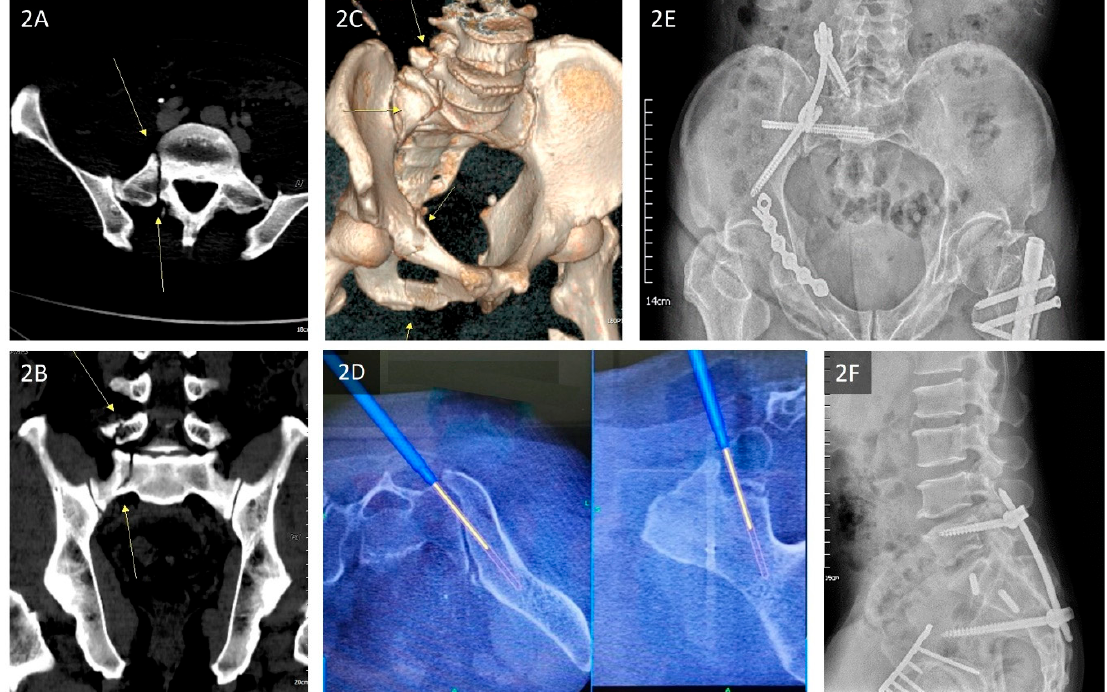
Figure 2. ( A – F ) Pre- and postoperative radiography and CT images of a 56-year-old man who was hit by a vehicle and had right superior and inferior rami fractures, a right L5 transverse process fracture, and a right sacral fracture with spinopelvic dissociation. The associated injury included a left femoral shaft fracture, right femoral shaft segmental fracture, and left medial malleolar fracture. ( A ) Axial CT view of the sacrum on admission demonstrating fracture lines (yellow arrows) over the right L5 transverse process; ( B ) coronal CT view of the sacrum on admission demonstrating fracture lines (yellow arrows) over the right sacrum; ( C ) 3D CT view of the pelvis showing right superior and inferior rami fractures (yellow arrows), a right L5 transverse process fracture (yellow arrows), and a right AO/OTA 61C1.3 and 54B3 type, Denis Zone II, sacral fracture (yellow arrows); ( D ) with the assistance of O-arm navigation, the optimal trajectory of the S2AI screw was set (O-arm and Stealth Station S7 Surgical Navigation System, Stryker); ( E ) postoperative view of the inlet pelvis—the sacral fracture was stabilized by triangular osteosynthesis with S2AI screws, and the right superior rami fracture was reduced and fixed with a pre-contoured locking plate; ( F ) postoperative lateral view of the sacral spine. Abbreviations: CT = computed